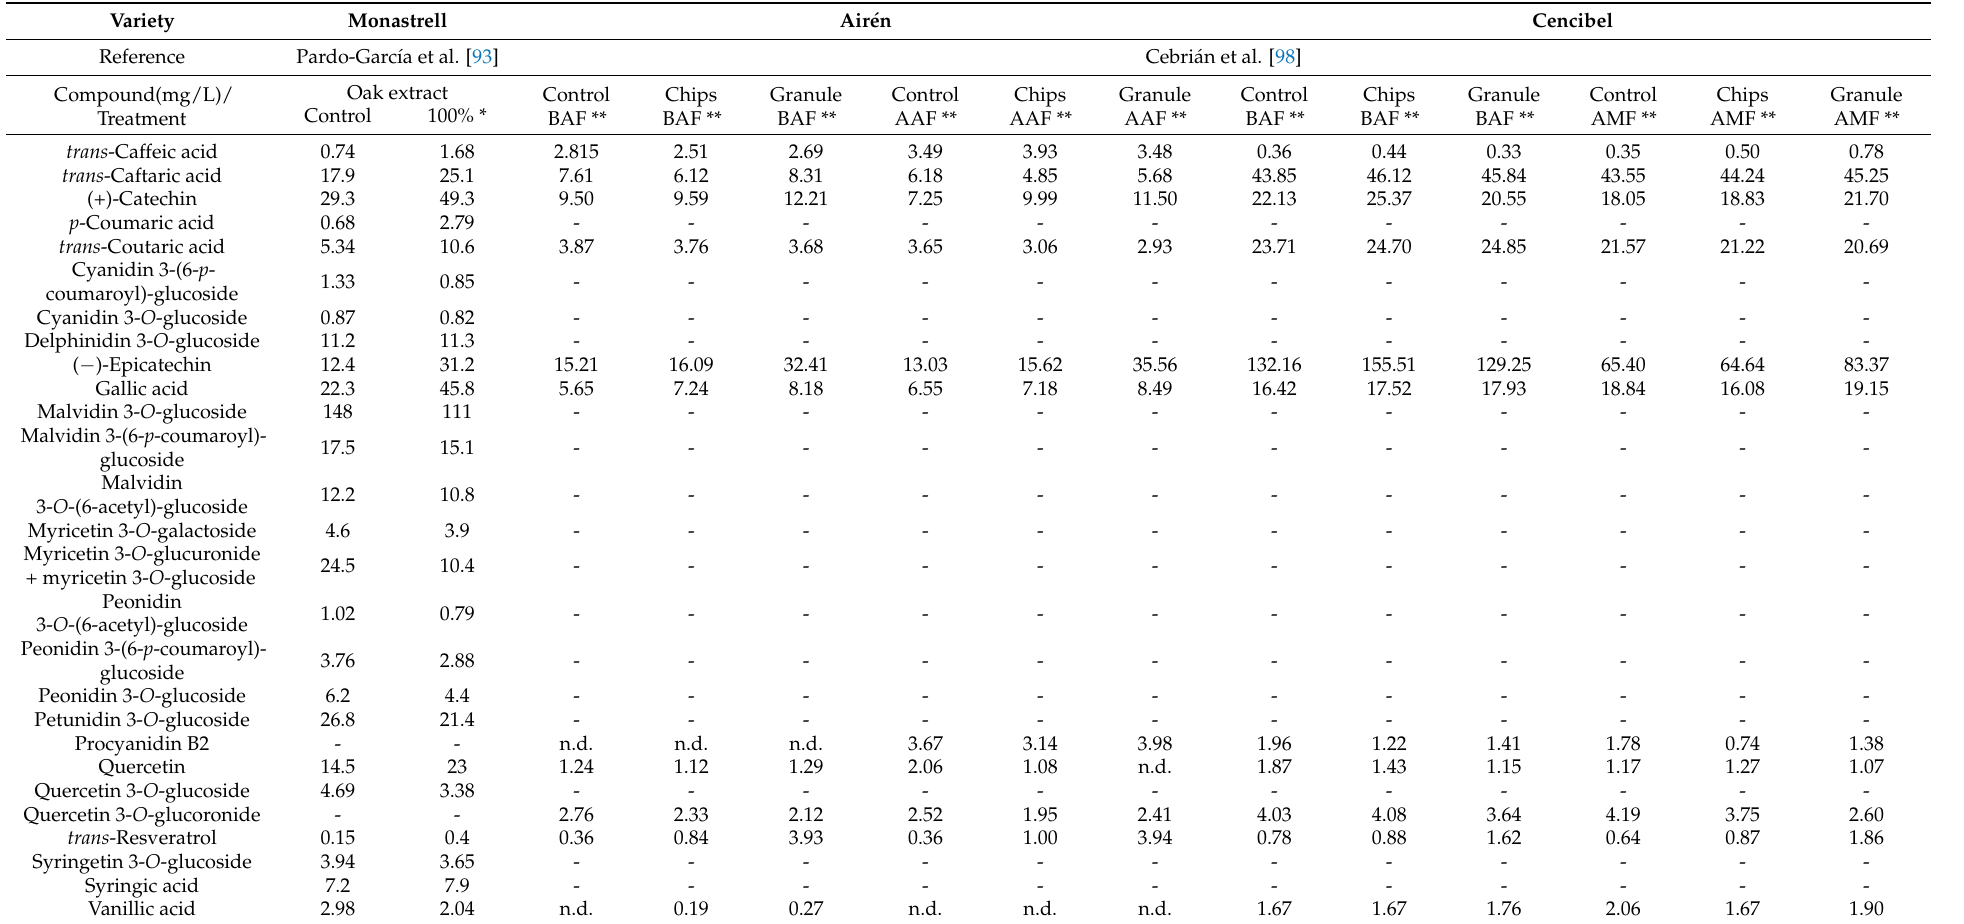
Table 2. Pardo-Garc í a et al. and Cebri á n et al.; Concentration of phenolic compounds in wines (mg/L) from Monastrell, Air é n and Cencibel varieties after grapevine/wine treatment with oak extracts. * 100%: one treatment with oak extract on seventh day post-veraison; ** BAF: Before alcoholic fermentation, AAF: after alcoholic fermentation, AMF: after malolactic fermentation; Portu et